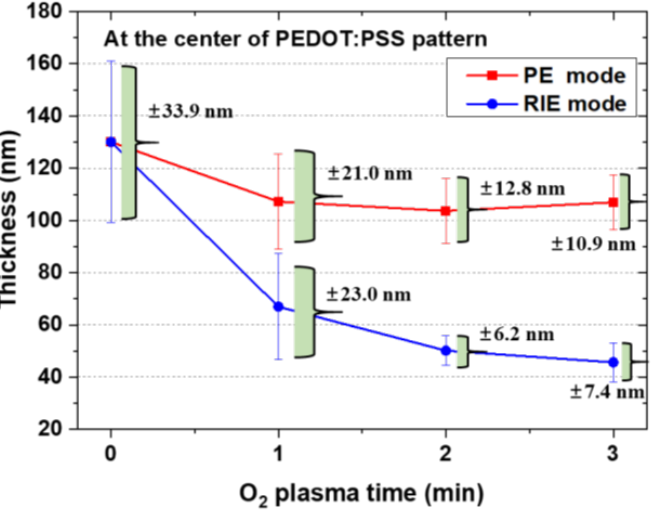
Figure 8. Changes in thickness and its variability at the center of the PEDOT:PSS patterns as a function of O 2 plasma exposure time using PE and RIE modes.